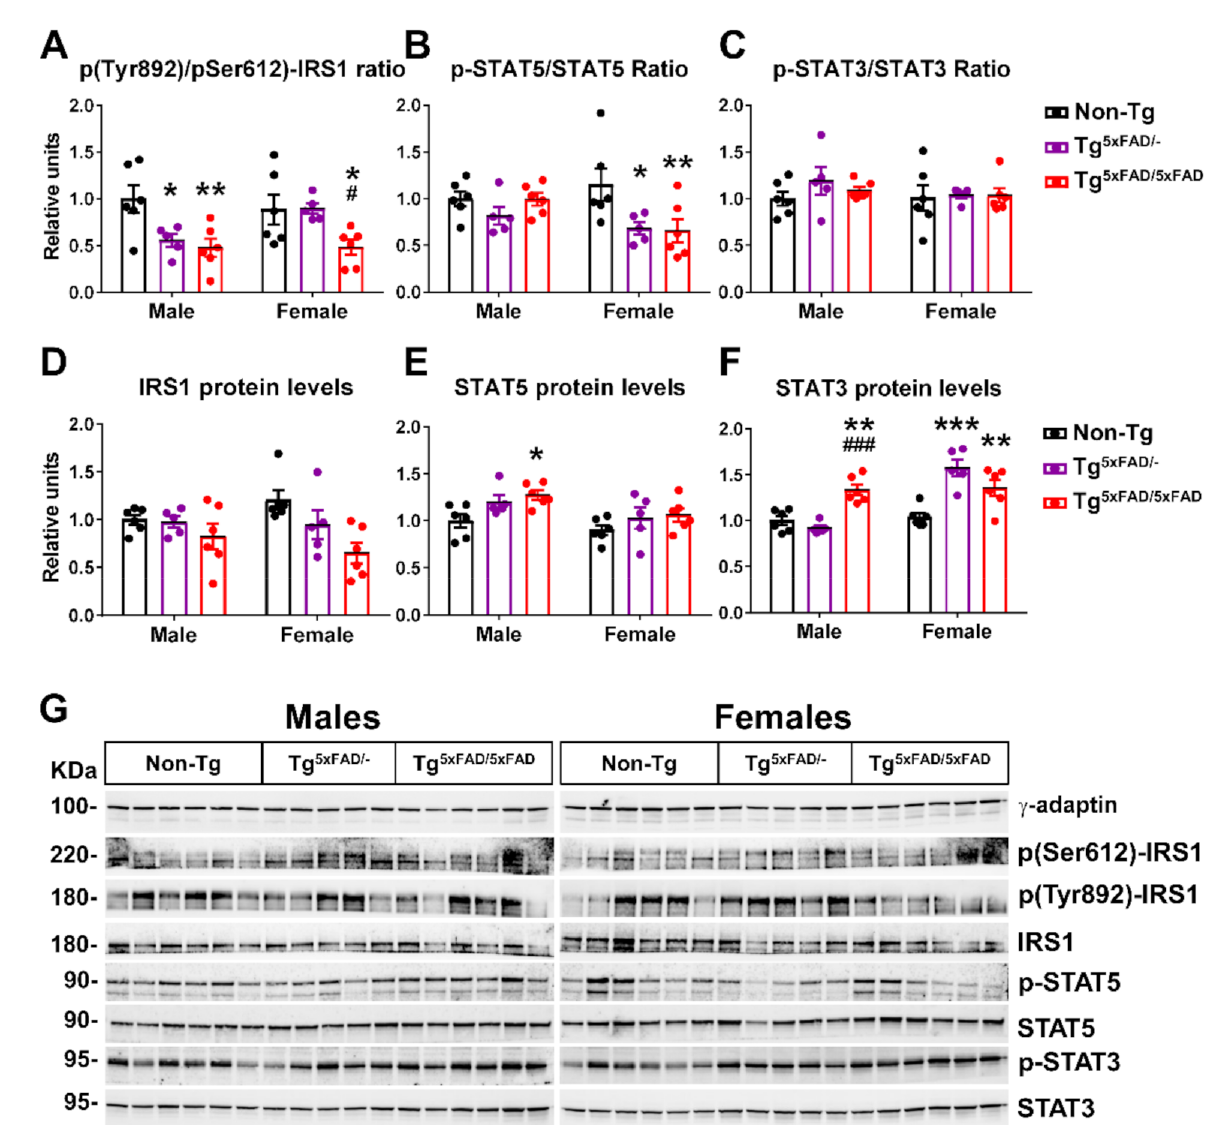
Figure 6. Insulin and leptin hypothalamic signaling were decreased in 5xFAD mice at 6 months of age, as shown by secondary messengers IRS1 and STAT5. ( A – F ) Representation of Western blot membranes and ( G ) densitometric evaluation of insulin receptor substrate 1 (IRS1) activation ratio (pTyr692-IRS1/pSer612-IRS1), IRS1 protein levels, signal transducer and activator of transcription 5 (STAT5) activation (p-STAT5/STAT5), STAT5 protein levels, STAT3 activation (p-STAT3/STAT3), and STAT3 protein levels ( n = 5–6 per group). Protein levels were normalized with γ -adaptin. Associated phosphorylations were normalized per activation/inhibition phosphorylation ratio (IRS1) or respective total protein levels (STAT5 and STAT3). Non-Tg males were set as 1 for protein relative units. Two-way ANOVA analysis with Tukey’s post hoc test: * = p < 0.05, ** = p < 0.01, *** = p < 0.001 versus same-sex non-Tg group; # = p < 0.05, ### = p < 0.001 versus same-sex Tg 5xFAD/-